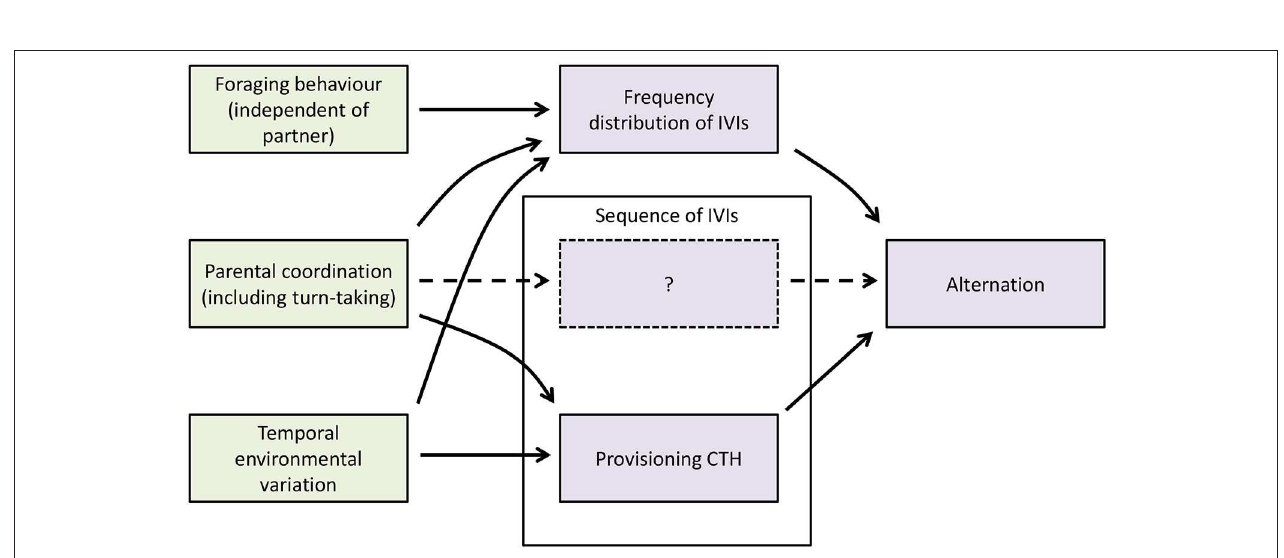
FIGURE 3 | The frequency distributions of provisioning CTH (correlated temporal heterogeneity) from simulated provisioning sequences ( n = 1,000) when parents provision independently (A) , and take turns (B) .